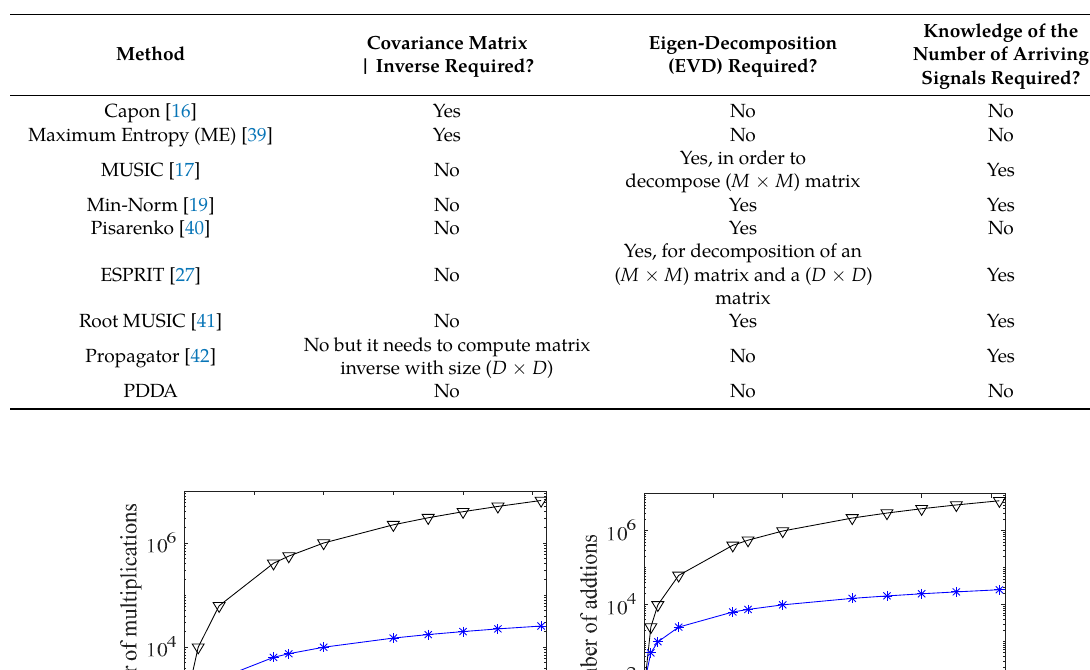
Table 2. Showing the complexity comparison between the propagator direct data acquisition (PDDA) and other angle of arrival (AOA) techniques.